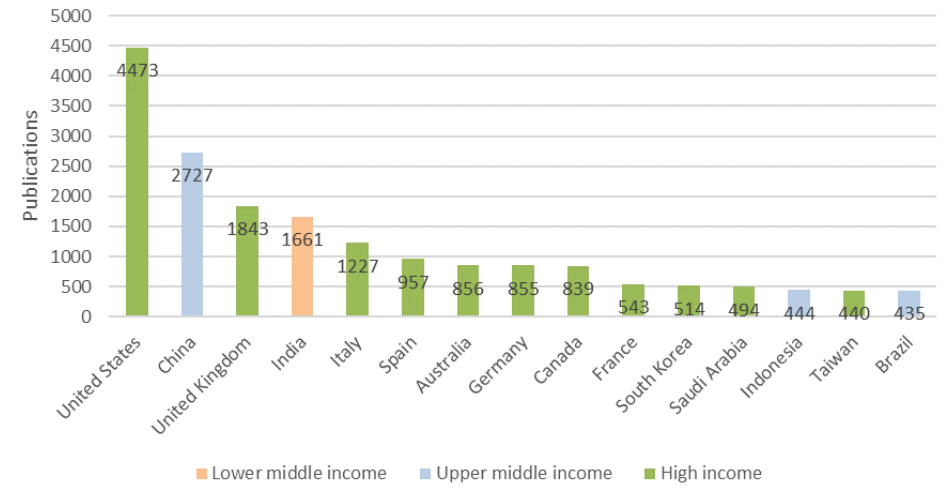
Figure 3. Top 15 most productive countries and their classification according to incomes (source Scopus).